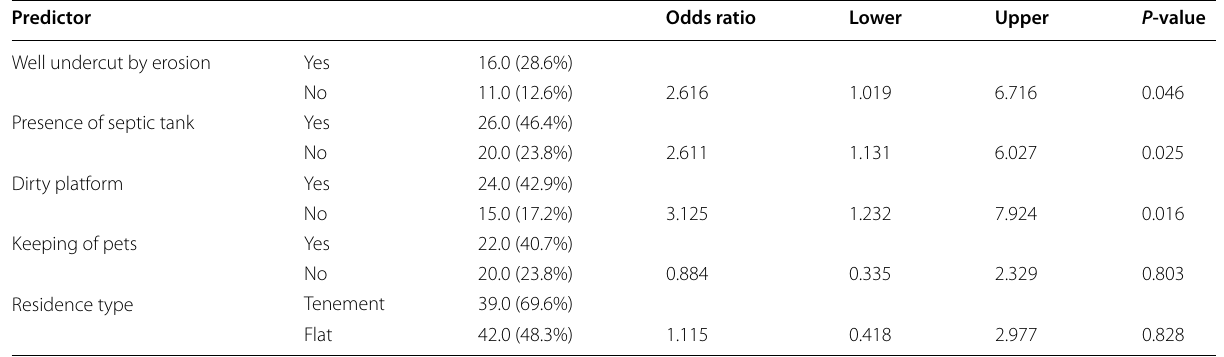
Table 7 Multivariate Logistic regression models of DEC in the assessed wells Predictor